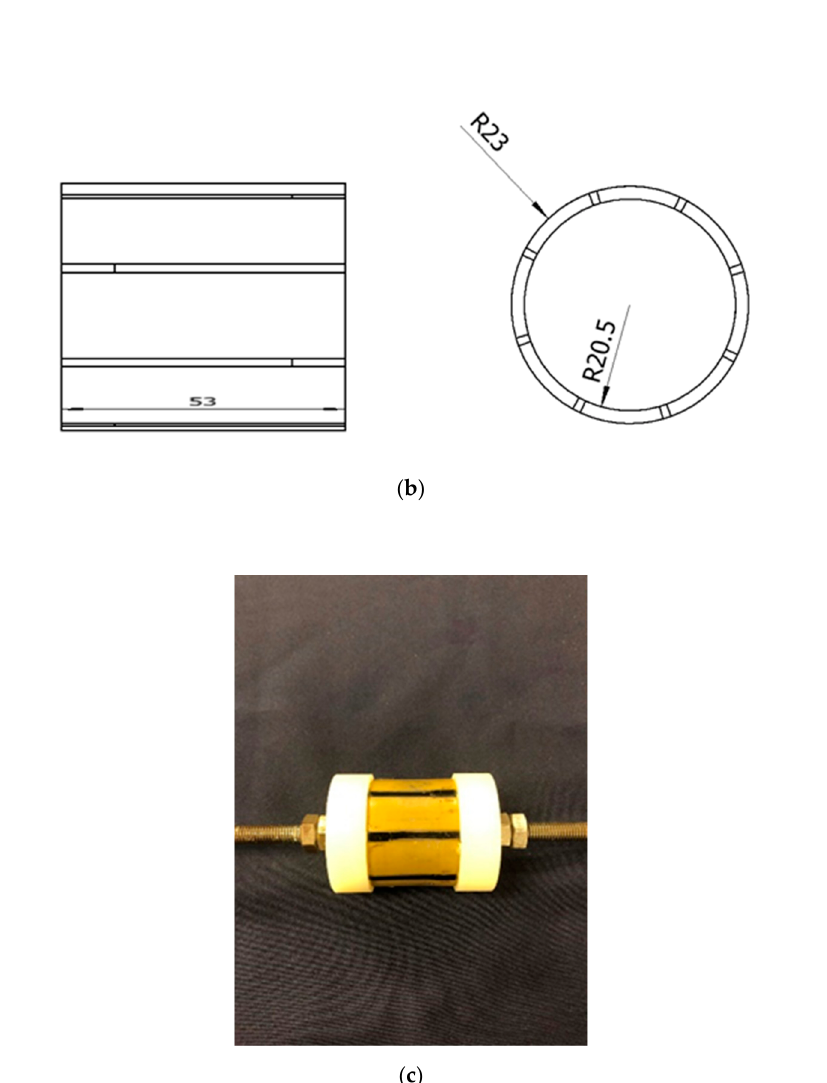
Figure 3. The piezoceramic transducer: ( a ) assembled piezoceramic transducer and components; ( b ) dimensions of the piezoceramic transducer (units in mm); ( c ) photo of the piezoceramic transducer.